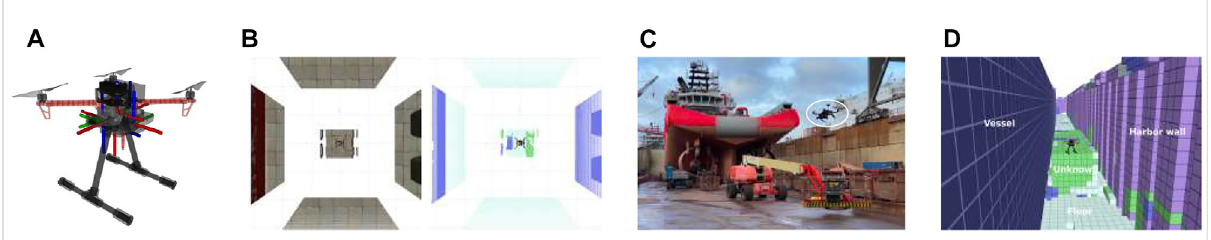
FIGURE 1 AUAV platform endowed withamultistereocamerasystem forautonomousdronenavigation applications. (A) The proposed design isgeneral enoughtoeasilyattachingatotalof5stereovisioncamerasaroundtheUAVframe(i.e.,front,left,right,back,bottom)for (B) high fi eld-of-viewRGB- D and semantic visual analysis. (C) Live-mission image of an autonomous UAV dockyard inspection task using our (D) semantic-aware receding horizon path planner and volumetric-semantic mapping